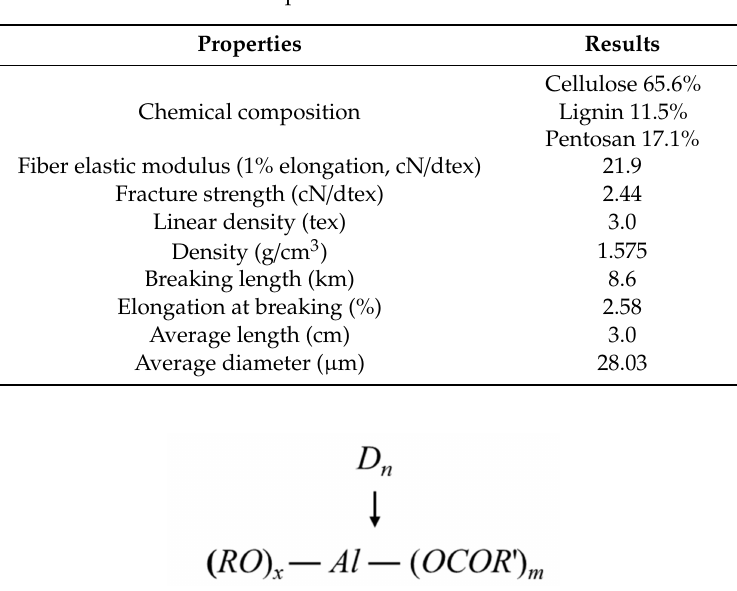
Figure 1. As-received raw bamboo fibers. Table 1. Properties of raw bamboo fiber.